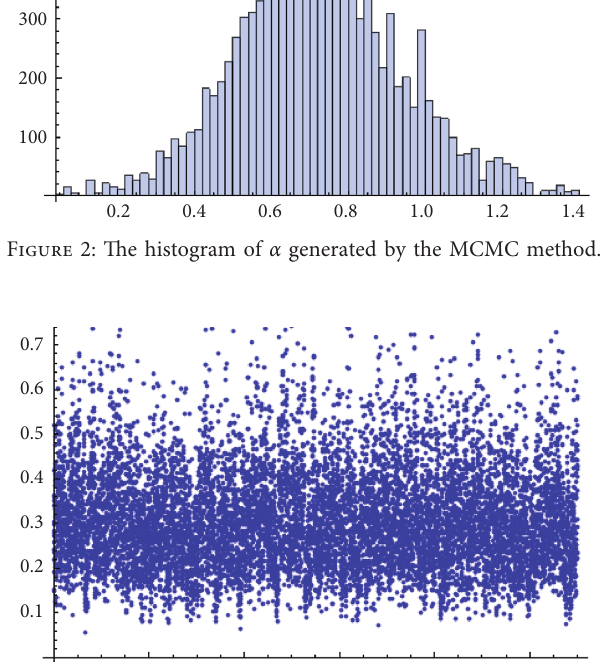
generated by the MCMC 1